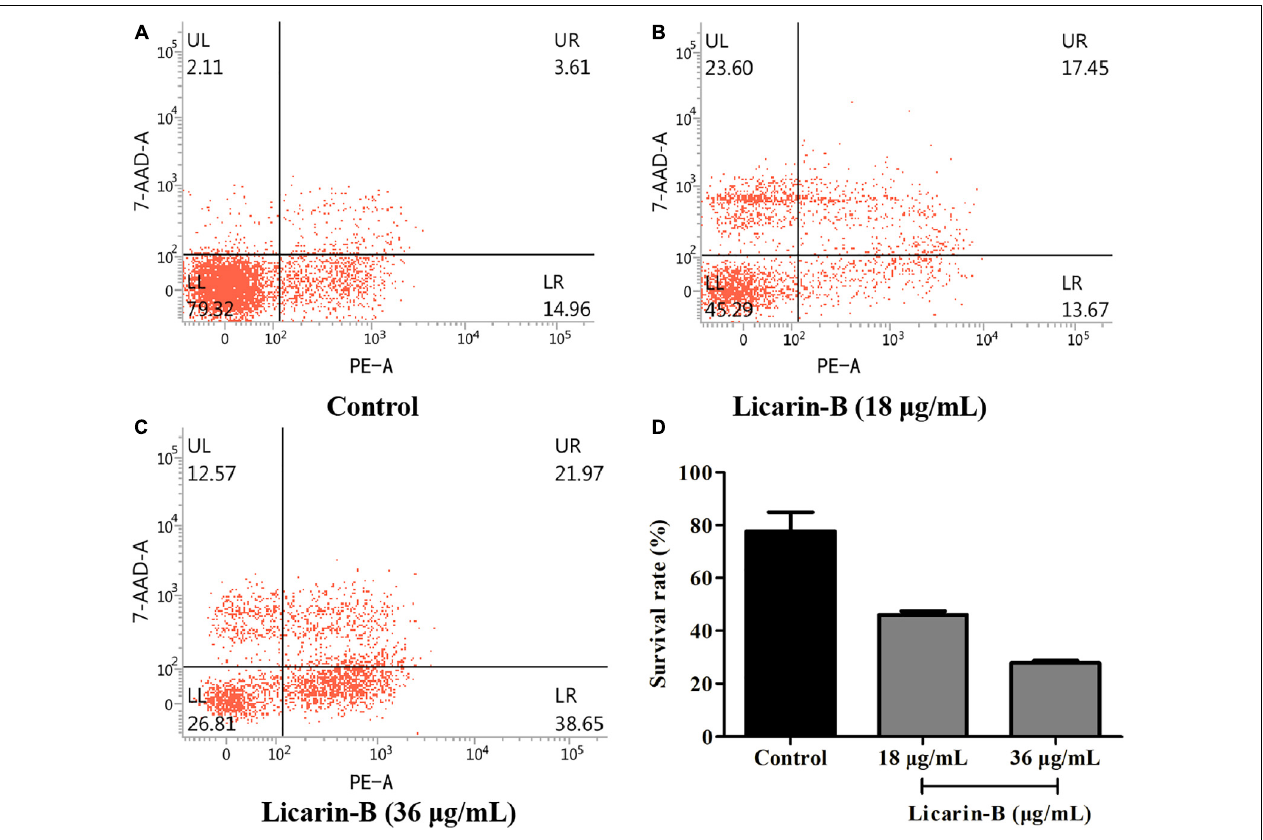
FIGURE 4 | Licarin-B induced death in T. gondii , as determined by flow cytometry. The control group showed a T. gondii survival rate of approximately 80% (A) . Licarin-B treatment significantly reduced the T. gondii survival rate, with rates of approximately 45 and 26% in the 18 and 36 µ g/mL licarin-B treatment groups, respectively (B,C) . The proportions of T. gondii surviving after treatment with licarin-B (18 or 36 µ g/mL) for 24 h are shown (D)